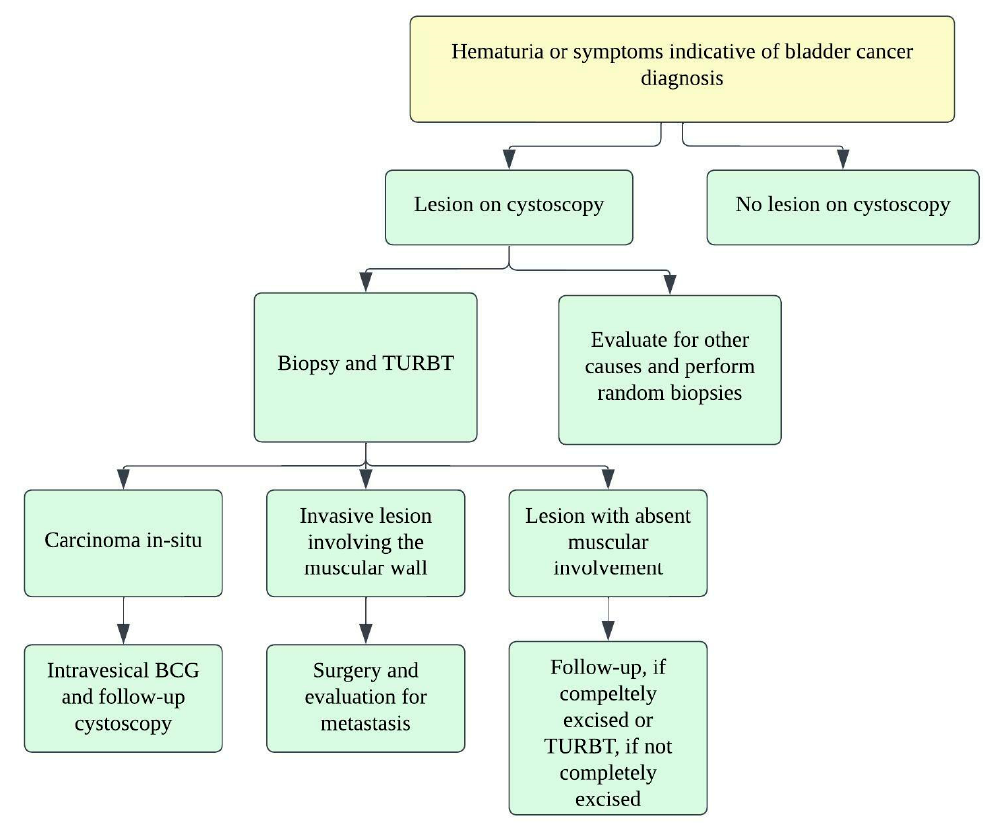
Figure 12. Treatment algorithm for urinary bladder carcinoma.